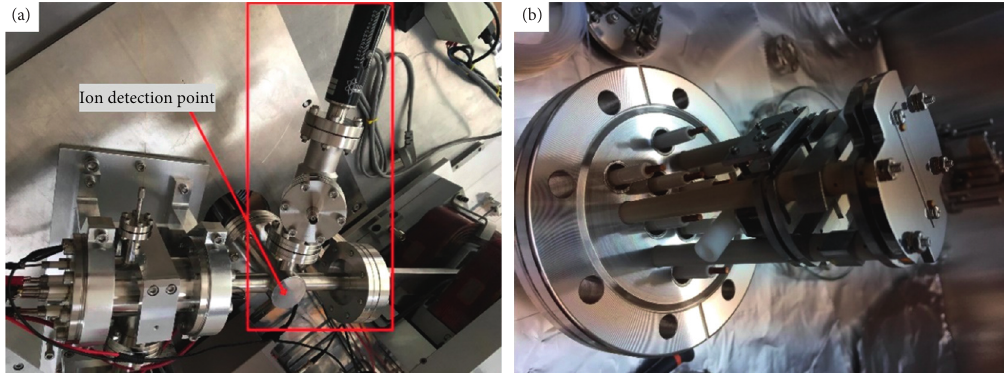
Figure 4: Photography of the homemade EI ionization source apparatus.